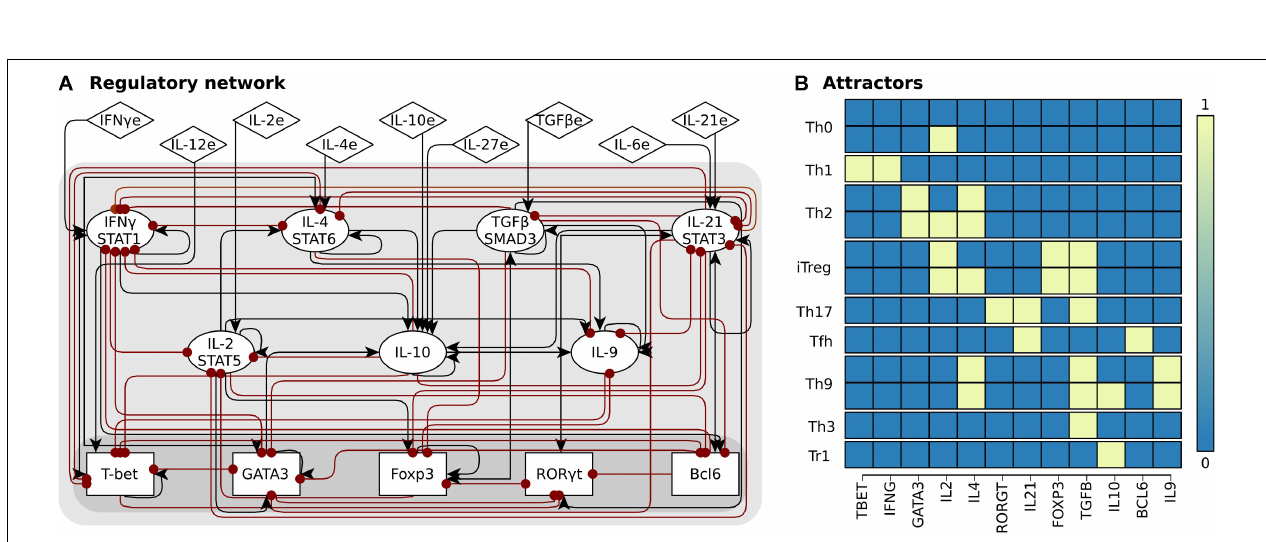
FIGURE 2 | CD4+ T cell transcriptional-signaling regulatory network. The regulatory network was constructed using available experimental data. (A) The network includes transcription factors (rectangles), autocrine cytokines and their signaling pathways (ellipses) and exogenous cytokines (diamonds). Interactions leading to activation are represented by black arrows, while those leading to inhibition with red dots. (B) Sample attractors of the system.